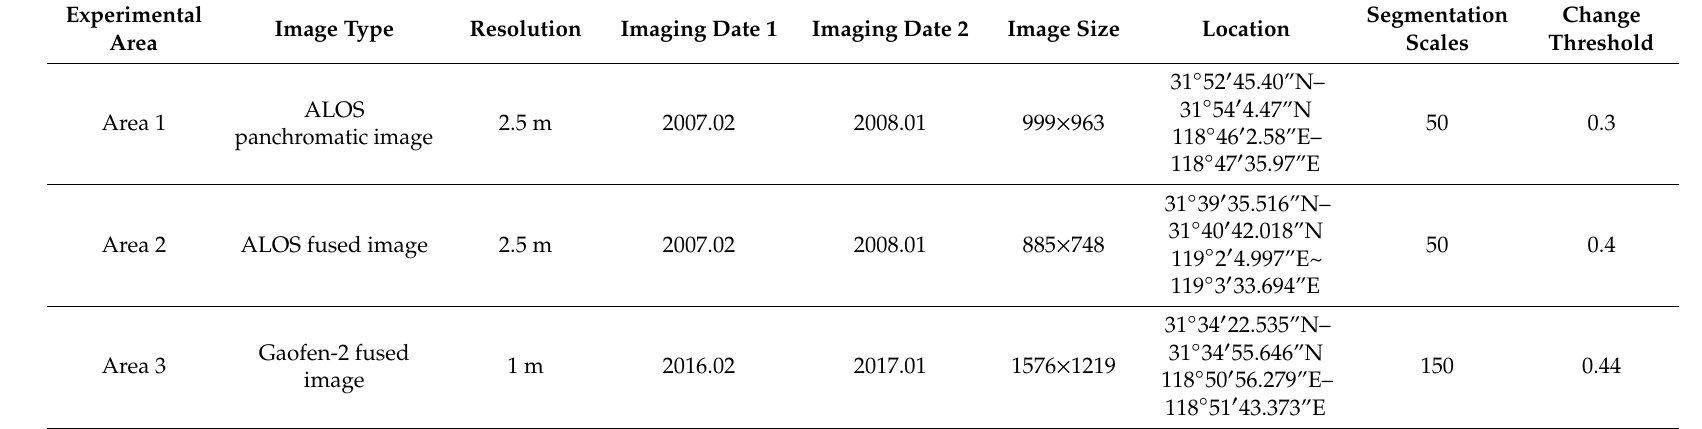
Table 1. Experimental data. ALOS: Advanced Land Observation